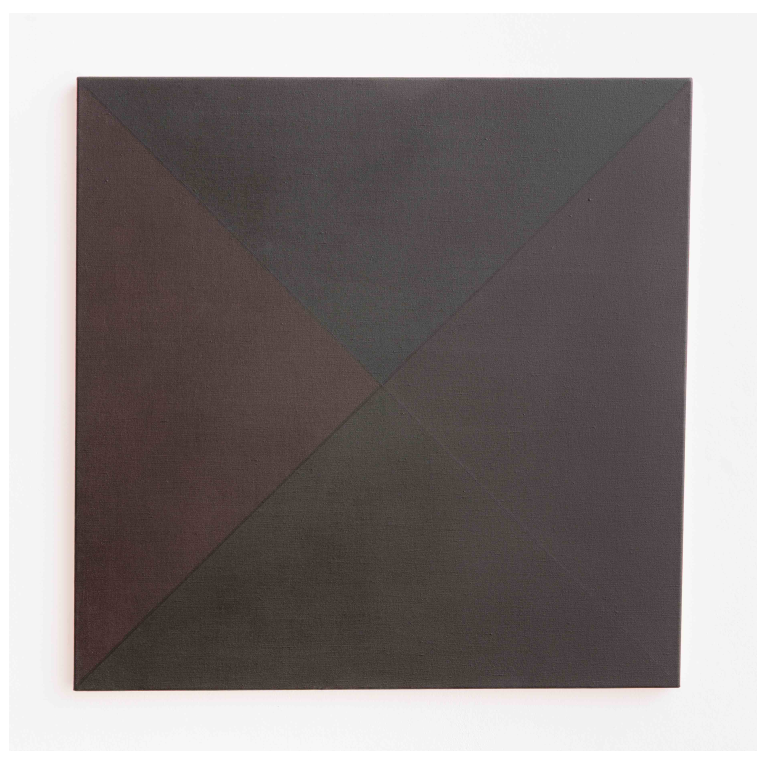
Figure 10: Katrina Blannin, Black Madonna , 2016, Acrylic on flax, 100 x